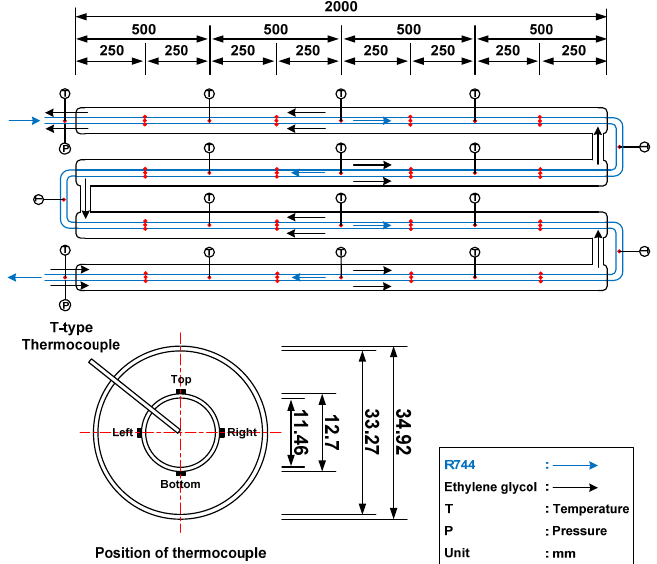
Figure 2. Schematic diagram of the evaporator for the R744 evaporation heat transfer test.